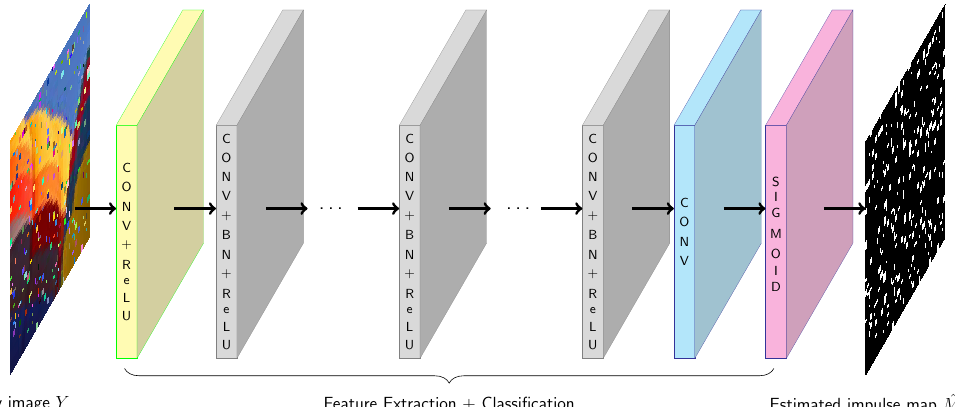
Figure 2. The architecture of the proposed network for impulsive noise